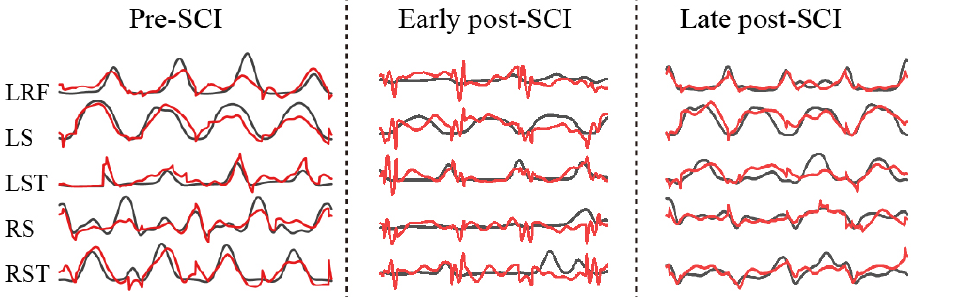
Figure 9. Examples of decoding various EMG activities during pre-SCI ( left ), early post-SCI ( middle ) and late post-SCI ( right ). Black lines, measured values; red lines, predicted